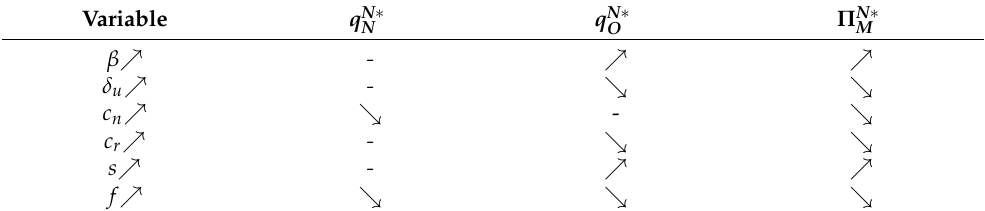
, q N ∗ , and Π N ∗ with respect to β , δ u , c n , c r , s , and f M N O